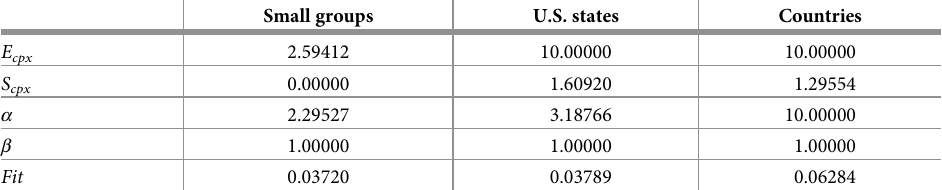
Table 2. Mean best parameter values after 1000 realization of model fitting via simulated annealing. Small